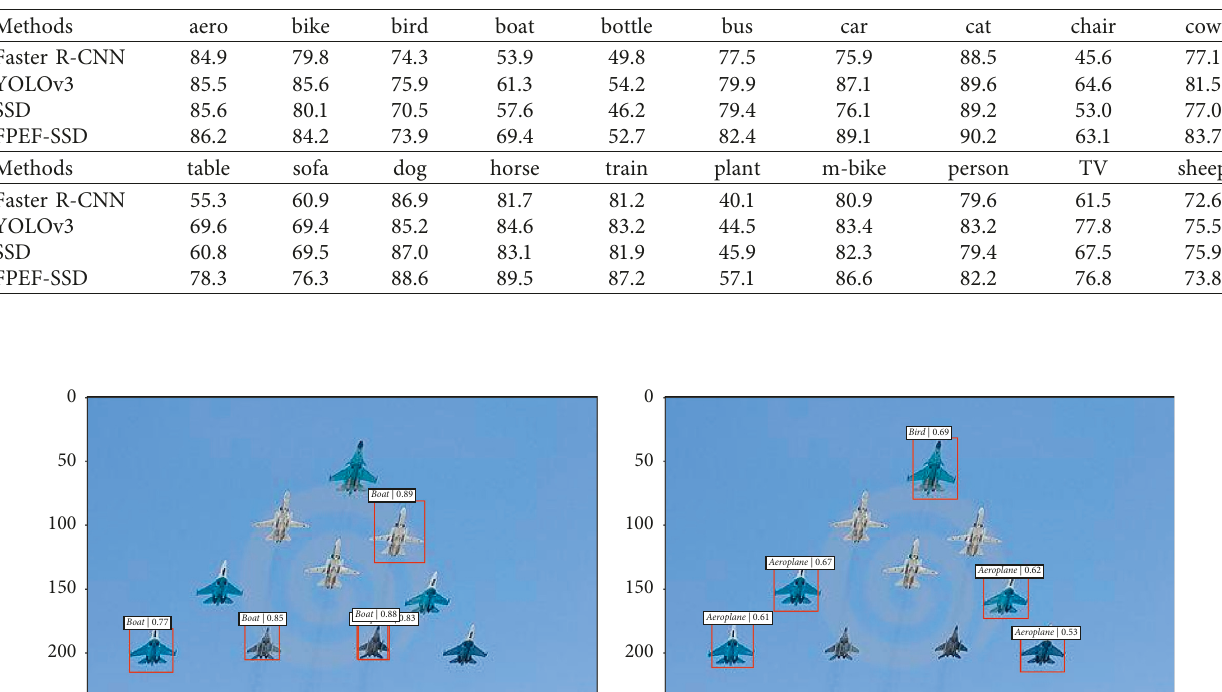
Table 5: Comparison of results of Pascal VOC 2012.